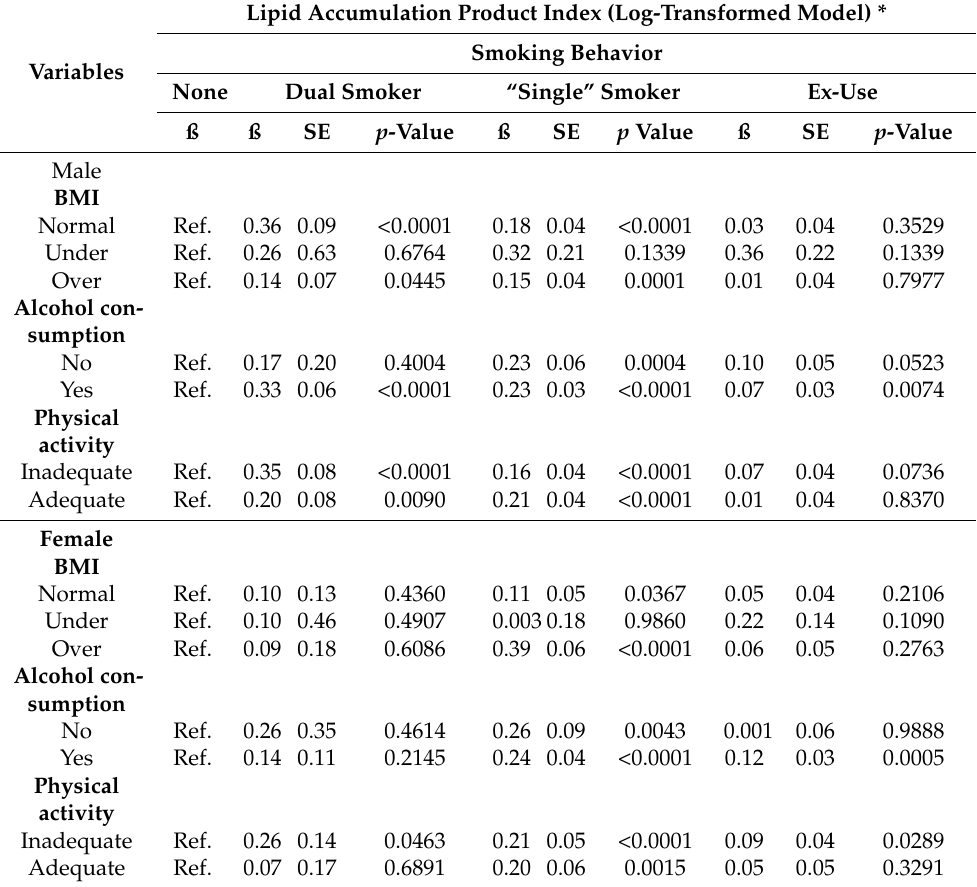
Table 3. Subgroup analysis stratified by independent